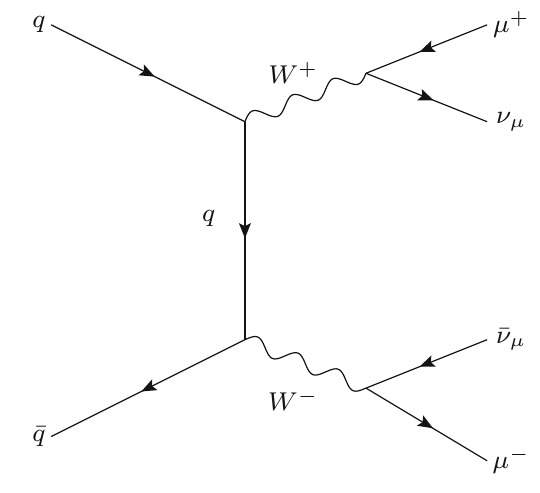
Fig. 7 Di-boson production